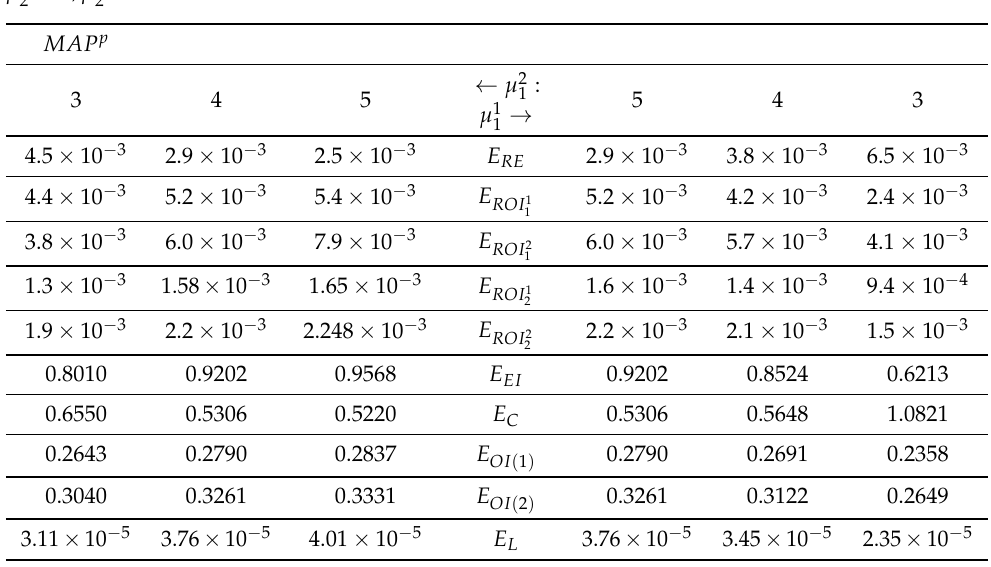
= 3, S = 3, s = 2, s 1 2 1